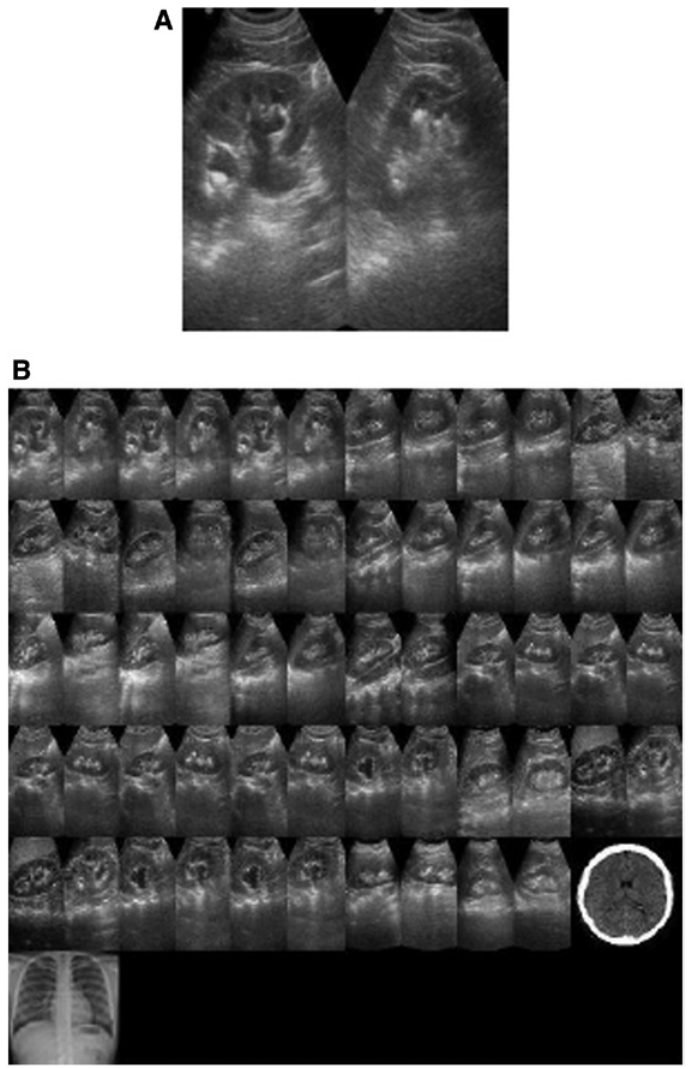
Figure 5: Sample Output Obtained in the Retrieval Process for Kidney Image. (A) Query image; (B) retrieved